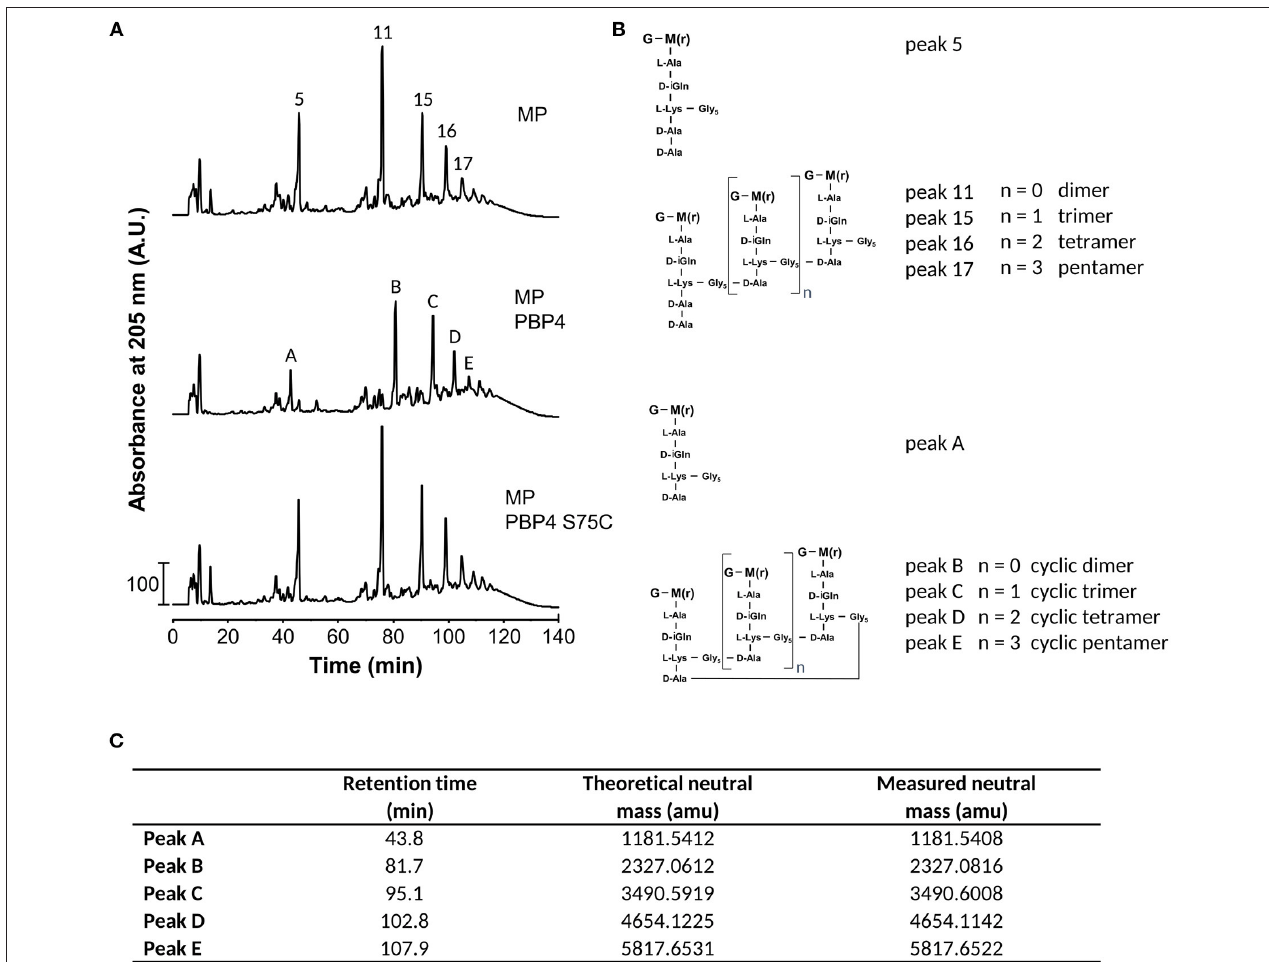
FIGURE 3 | PBP4 forms cyclic muropeptides in vitro . (A) HPLC chromatograms of muropeptides from S. aureus SH1000 incubated with PBP4 or the inactive version PBP4(S75C). (B) Proposed structures of muropeptides present in the fractions in panel A and consistent with the molecular weight determined by mass spectrometry. G, N -acetylglucosamine; M(r), N -acetylmuramitol; L-Ala, L-alanine; D-iGln, D-isoglutamine; D-Ala, D-alanine; L-Lys, L-lysine; Gly, glycine. (C) Theoretical and measured neutral atomic mass units (amu) determined by MS of fractions collected from the PBP4 products in the middle chromatogram in (A)